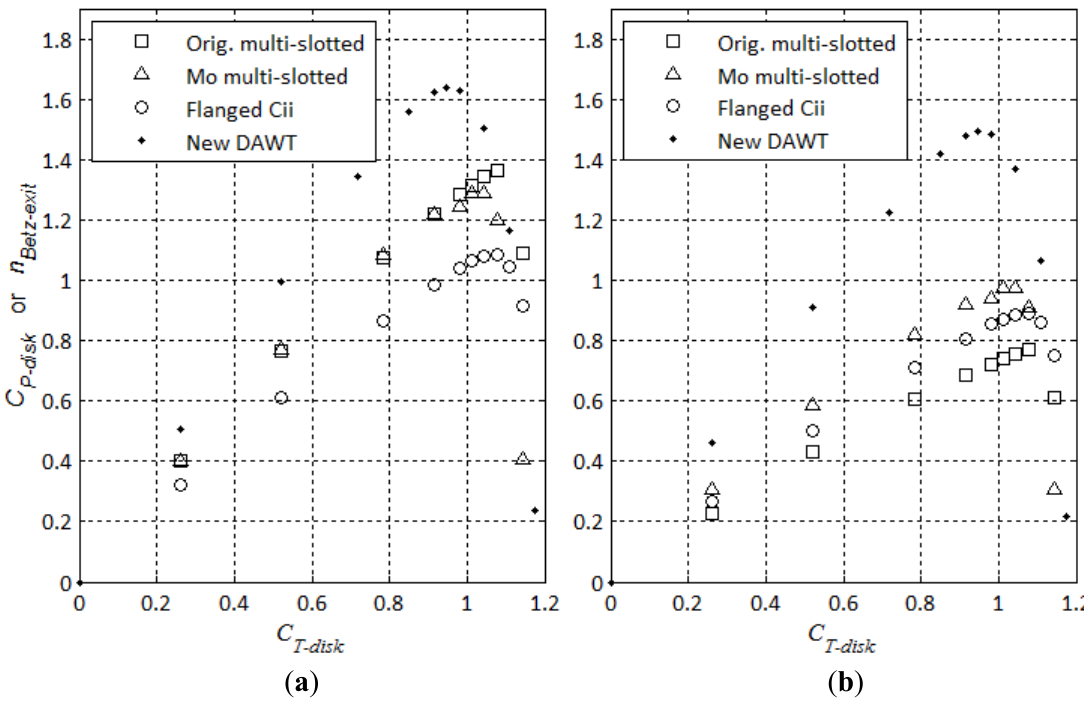
Figure 10. ( a ) Ct vs. Cp for benchmark DAWTs and new DAWT; ( b ) Ct vs. nBetz (based on projected diffuser area) for benchmark DAWTs and our new